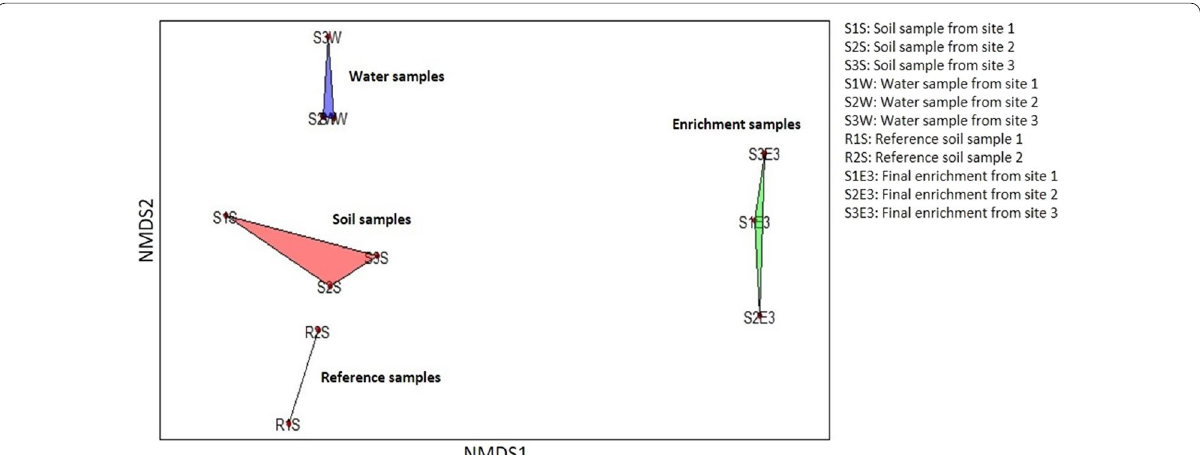
Fig. 2 Non-metric multidimensional scaling (NMDS) ordination plot showing differences in microbial community compositions of the water, soil, enrichment, and reference unpolluted soil samples based on community composition at the genus